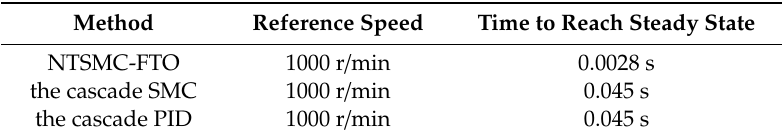
Table 5. The comparative simulation results of start up.